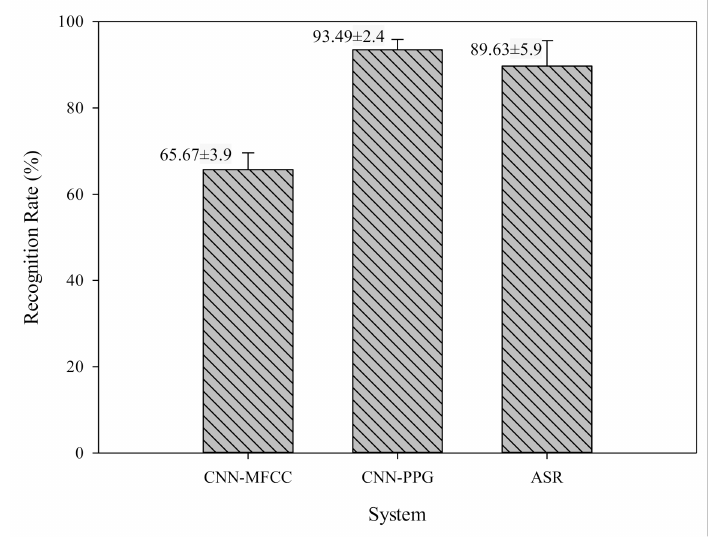
Figure 4. The average speech recognition rate (%) of CNN–MFCC, CNN–PPG, and ASR-based SCR systems in a test repeated 10 times.